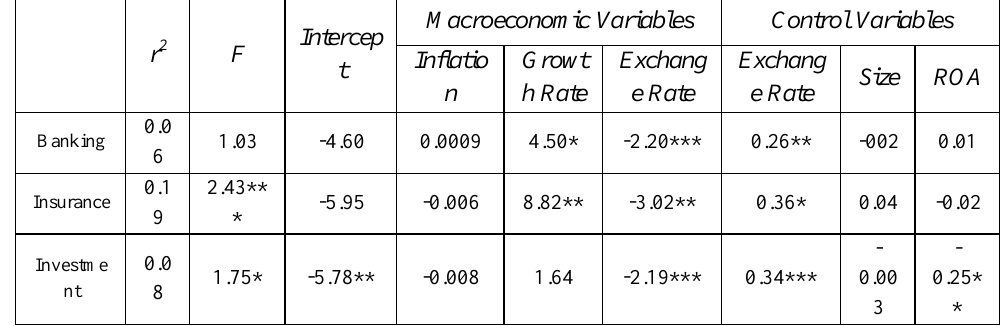
Table 10: Effect of macroeconomic variables on jump